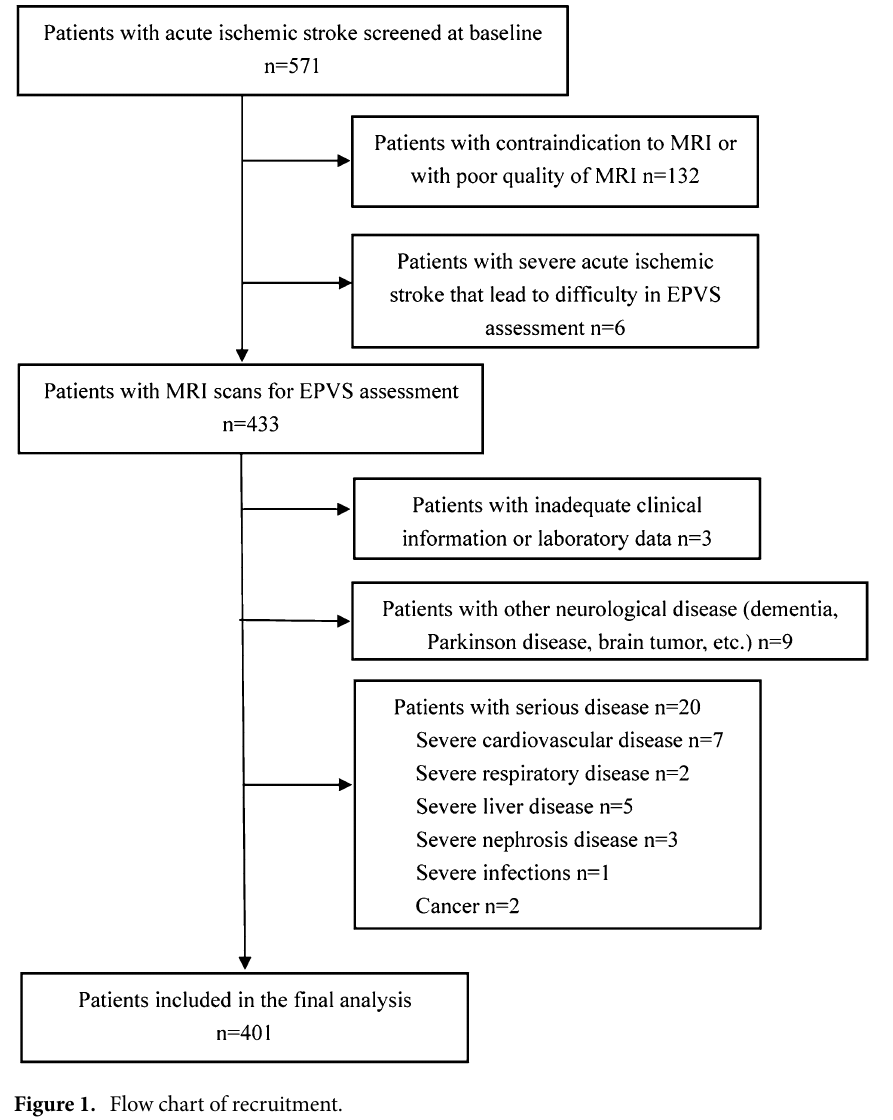
Figure 1. Flow chart of